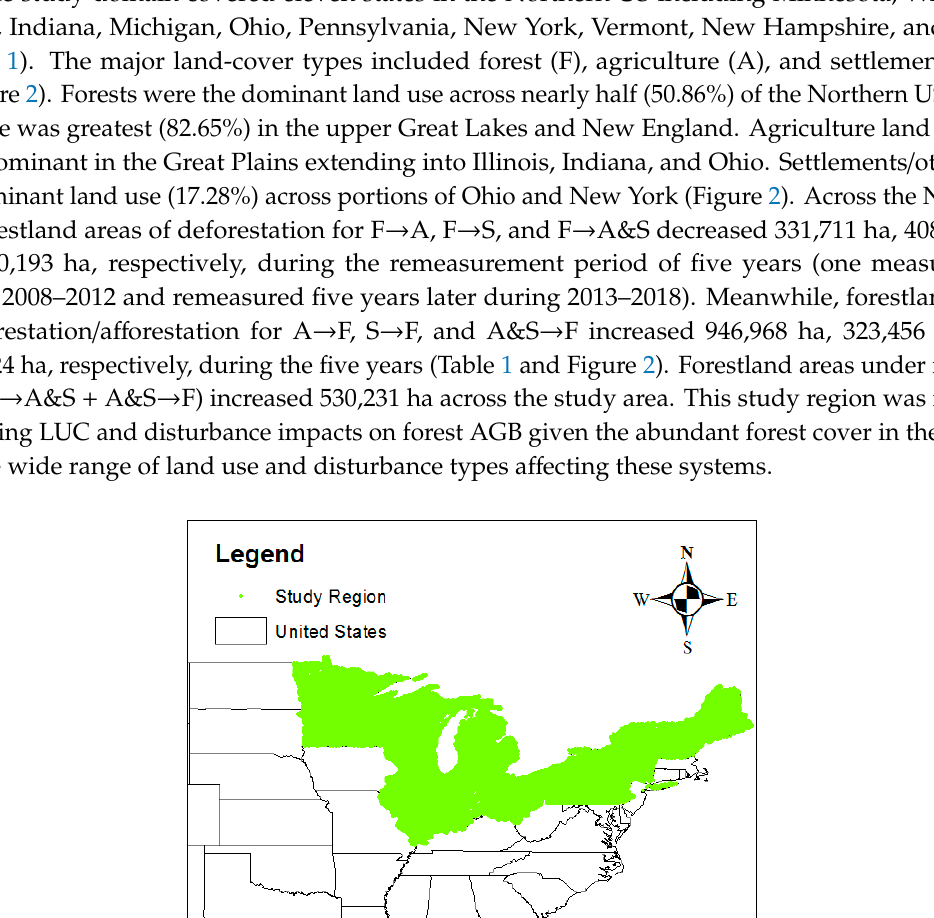
Figure 2. Percent land use ( a , b , c ) and land use change (LUC) ( d , e , f ) by general land use classes (forest, agriculture, and settlements/other) summarized for discrete hexagons across the Northern US during the remeasurement period of five years. Land use change was estimated for each hexagon that had at least eight sample plots within it, with change calculated as the difference in the percent land use between time one and two by land use category [5]. 2.2. National Forest Inventory Data Comprehensive NFI data were extracted from the US Department of Agriculture Forest Service, Forest Inventory and Analysis (FIA) database (https://apps.fs.usda.gov/fia/datamart/datamart.html) in 11 states of the Northern US for a total of 78,458 plots (Figure 3, with one measurement between 2008 and 2012 remeasured five years later between 2013 and 2018). Each permanent ground plot was composed of four smaller fixed-radius (7.32 m) subplots spaced 36.6 m apart in a triangular